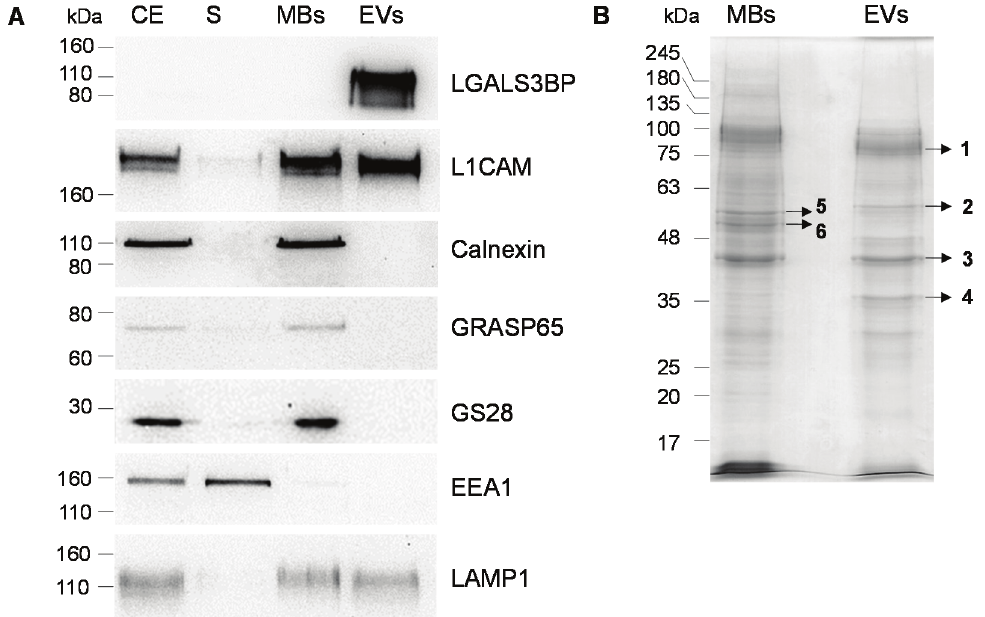
Figure 2. Comparison of protein profiles of MBs and EVs from OVMz cells. ( A ) Immunoblotting of cellular extracts (CE), post-100,000 g supernatant from MBs isolation (S), MBs and EVs. Ten μg of total protein were applied per lane with the exception of EVs in the incubation with LGALS3BP where three μg of total protein were used. Detection was by the chemiluminescent method. Results were representative of three experiments; ( B ) SDS-PAGE analysis of proteins of MBs and EVs. Ten μg of protein were applied per lane. Protein detection was with Coomassie